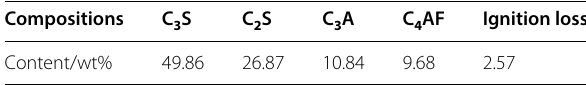
Table 3 Mineralogical properties of cement.